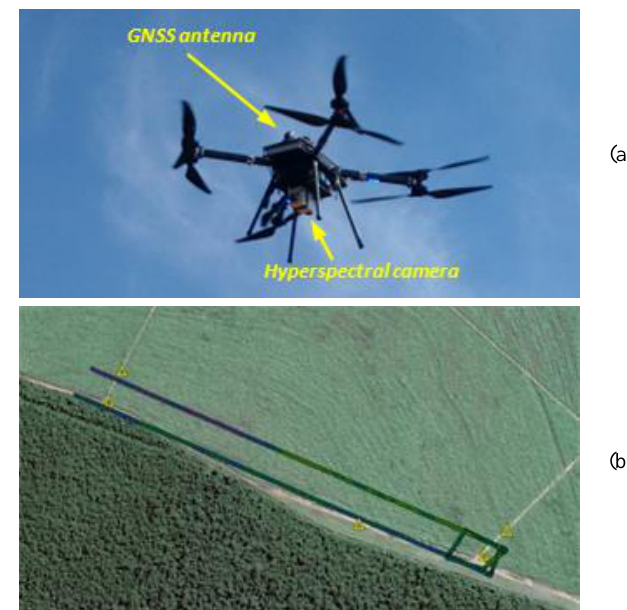
Figure 4. (a) UAV equipped with a hyperspectral camera and GNSS receiver. (b) Distribution of five GCPs (triangles) and trajectory followed by the UAV to acquire hyperspectral